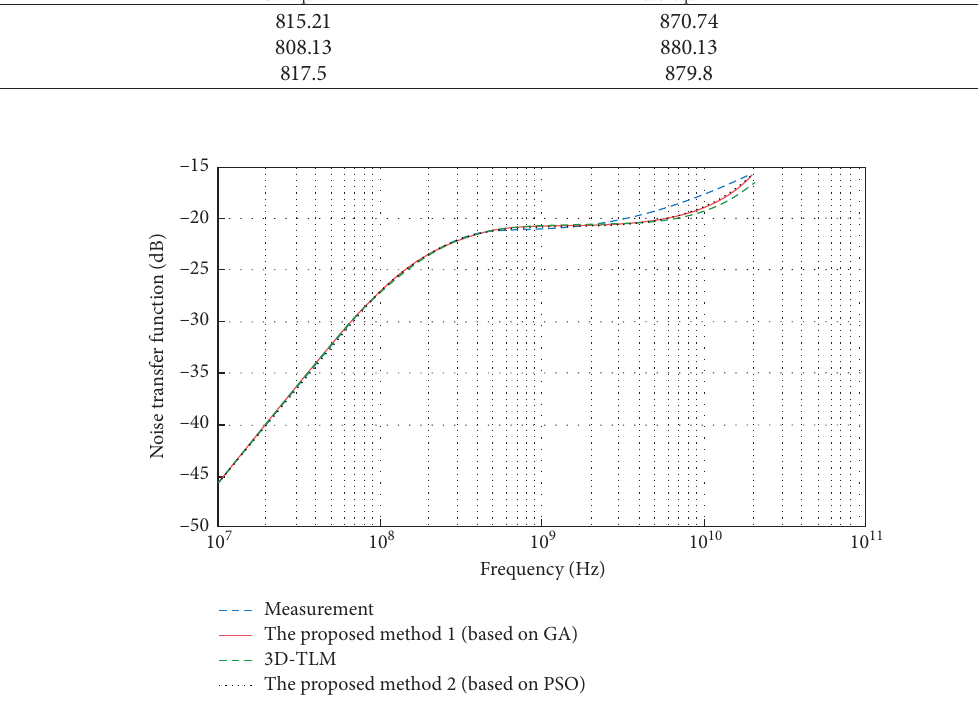
Figure 15: The proposed method, measured, and 3D-TLM noise transfer function of TSV-contact